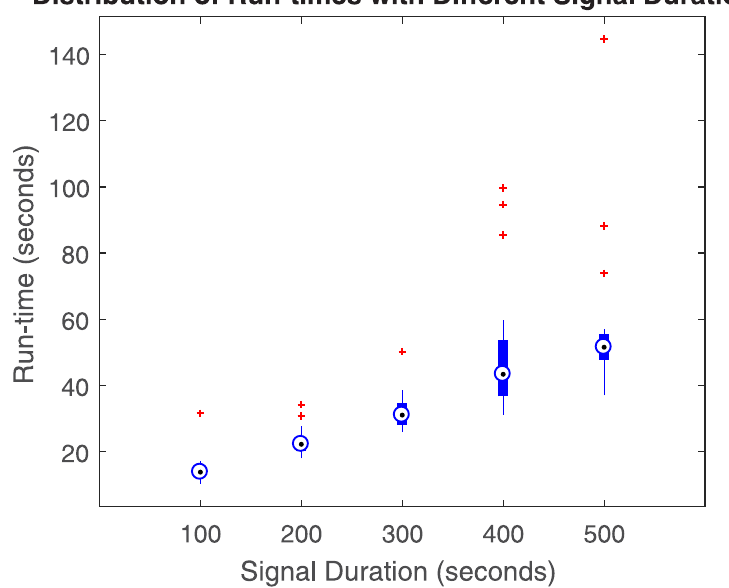
Fig 10. Run-time vs signal length. Figure shows boxplots of the run-times of the proposed approach with different signal lengths. The black dots with blue circle in the middle of each boxplot denote median. The bottom and top of each blue box are the 25th and 75th percentiles of the sample, respectively. The red markers denote the